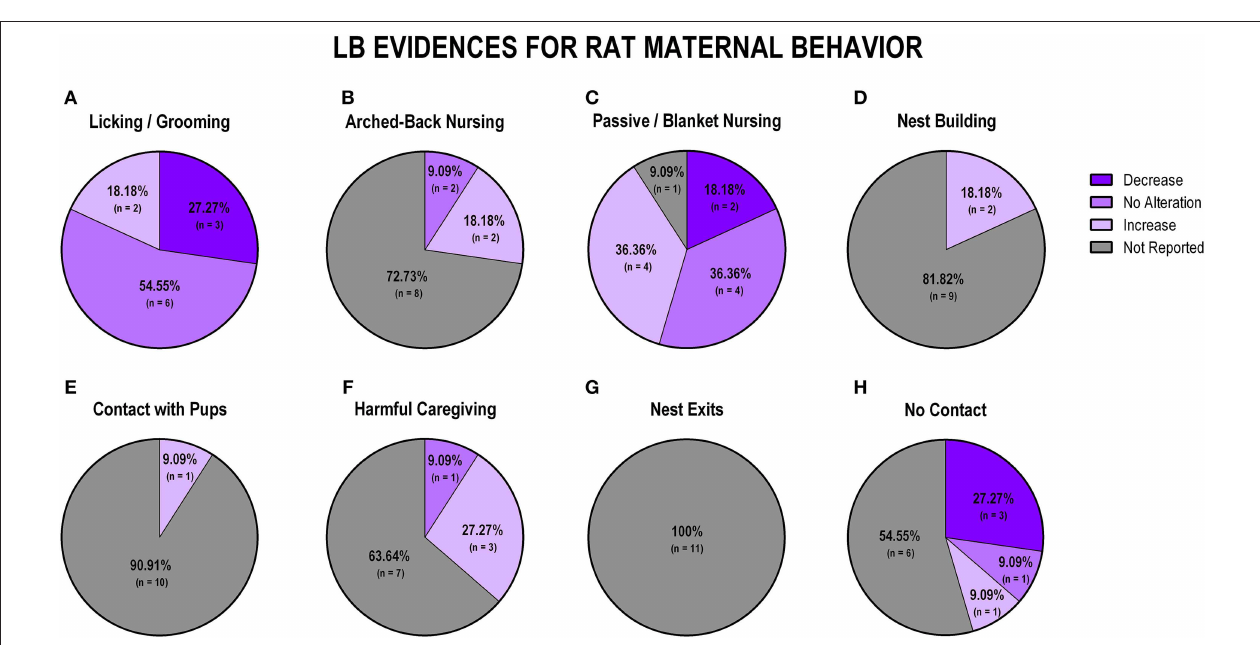
Regarding passive/blanket nursing, no alteration (36.35%) and increase (36.35%) were both reported in four studies, respectively ( Figure 7C ). Only 2 (18.2%) studies reported nest